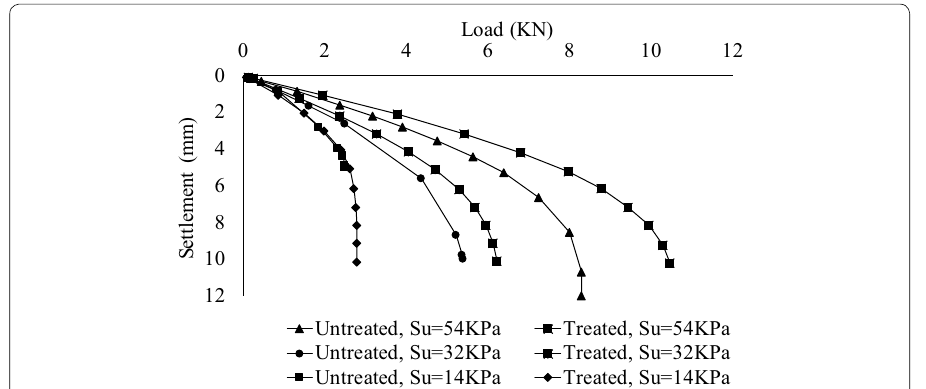
Fig. 10 FEM analysis of sand columns on clayey soil of different shear strength